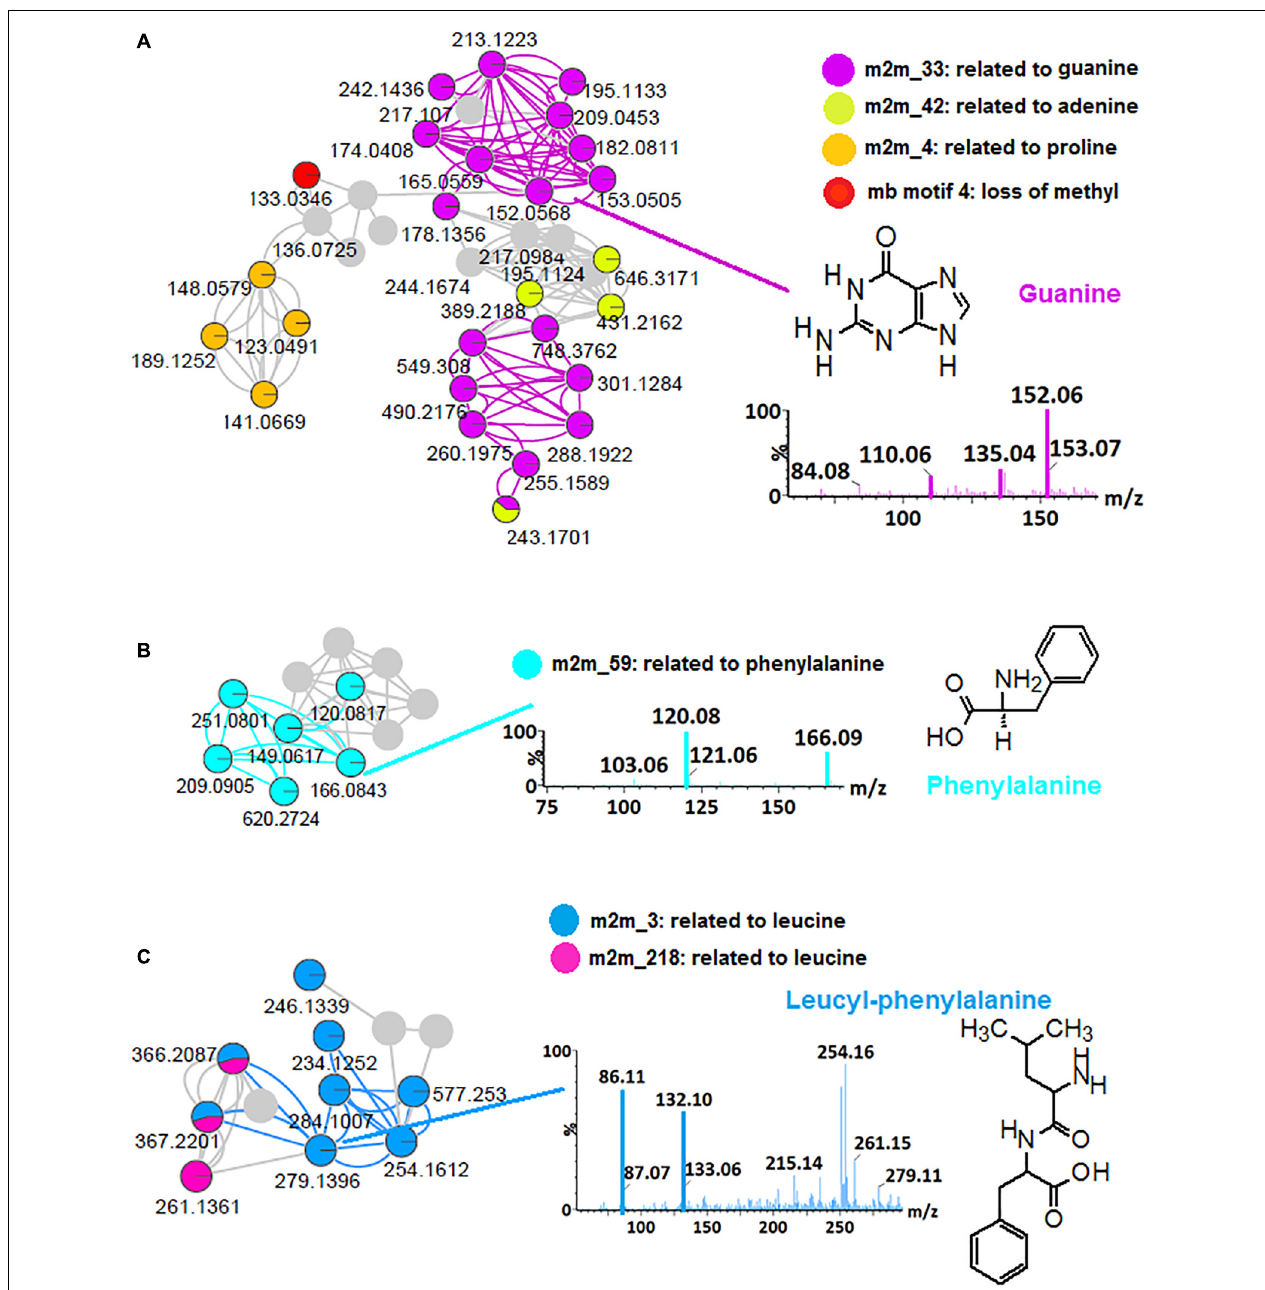
FIGURE 1 | MS2LDA-driven metabolite annotation. Subnetworks extracted from an MS2LDA-enhanced molecular network of positive electrospray ionization (ESI + ) MS/MS spectra obtained from B. laterosporus methanolic extracts ( Supplementary Figure 3 ). Colored nodes represent the recognized substructures related to Mass2Motifs (m2m), (A) m2m_33: related to guanine, m2m_42: related to adenine, m2m_4: related to proline and mb motif4: loss of methyl group, (B) m2m_59: related to phenylalanine, (C) m2m_3 and m2m_218 related to leucine. The mass spectral network views were obtained via the MolNetEnhancer